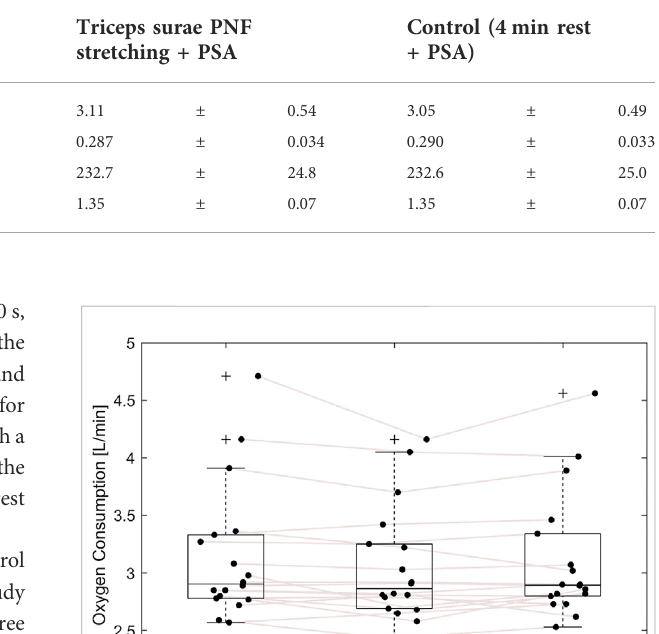
TABLE 1 Mean ± SD. Results for the parameters oxygen consumption, ground contact time, stride length, and stride frequency for the three crossover-design conditions. The two intervention conditions were quadriceps PNF stretching + post-stretching activation (PSA) and triceps surae stretching + PSA. Control condition was no stretching (4 min rest) + PSA (control).